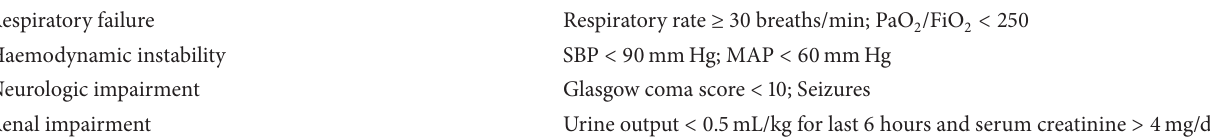
Table 1: Definitions of organ failure.